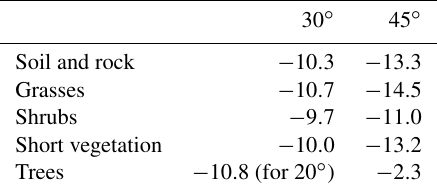
Table B5. Average backscatter values from Ulaby and Dobson (1989) for the C band at VV polarization for look angles of 30 and 45 ◦